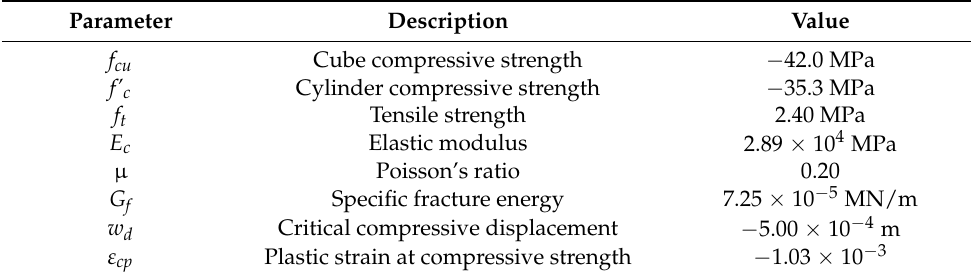
Table 7. Key input parameters of the cementitious matrix.